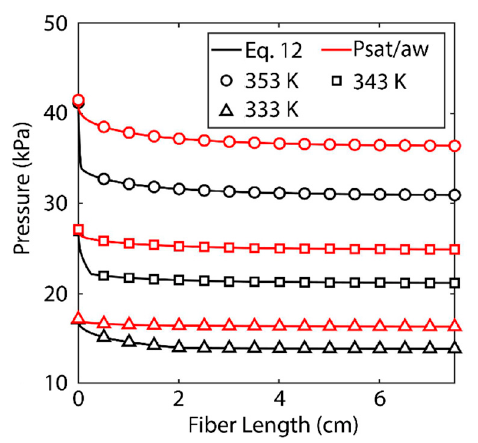
Figure 5. Saturation pressure as a function of fiber length. Black lines indicate saturation pressure as calculated using Equation (16). Red lines indicate saturation pressure as determined using An- toine’s equation This study is based on shell-side feed. Here, the inner radius of the hollow fiber is 350 µm and the thickness of media is 300 µm. The R / a was kept at 0.35, the fibers’ lengths are 5 cm, the feed is velocity 5 m/s, and the pressure in permeate channel was kept at 5 kPa. We assumed membrane tortuosity of 2, pore size diameter of 400 nm, and a porosity 0.5 of for the membrane media.